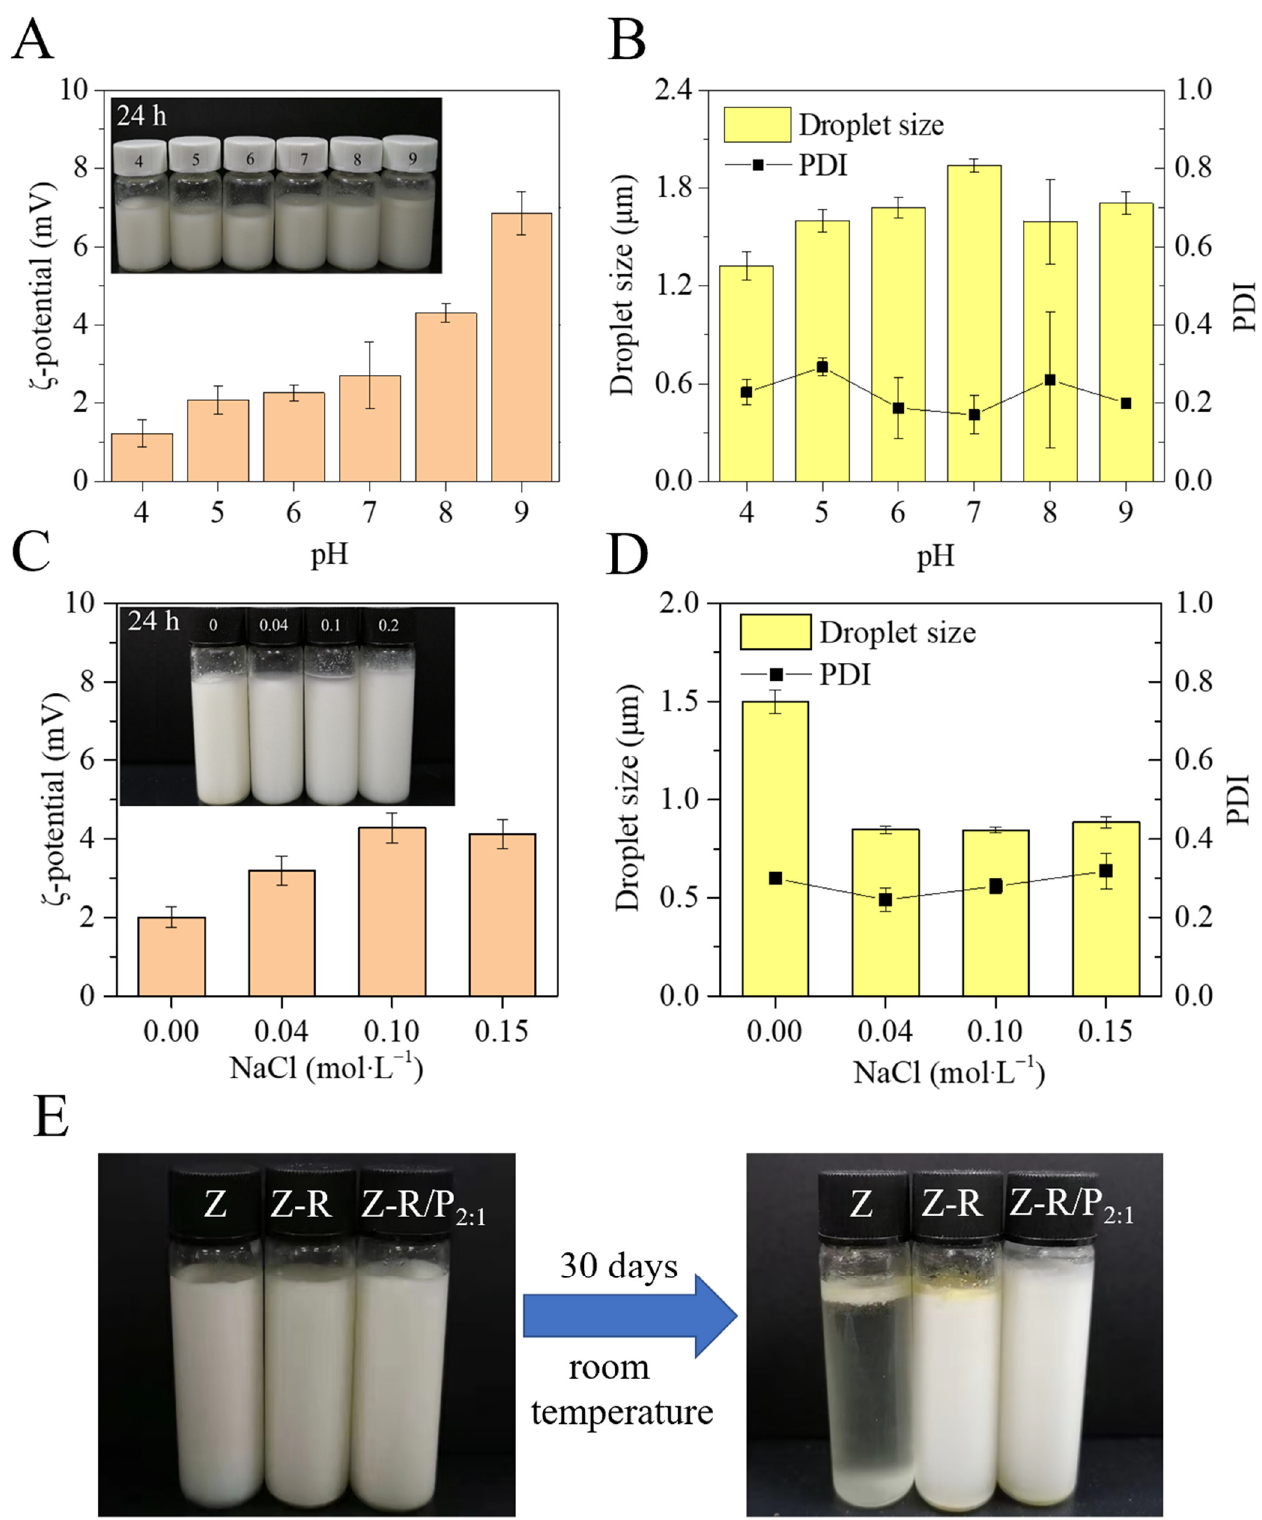
Figure 8. Effect of different pHs on the appearance, ζ -potential ( A ), droplet size and PDI ( B ) of Z-R/P 2:1 -stabilized emulsions after 24 h of storage. Effect of different NaCl concentrations on the appearance, ζ -potential ( C ), droplet size and PDI ( D ) of Z-R/P 2:1 -stabilized emulsions after 24 h of storage. The appearance ( E ) of emulsions stabilized by Z, Z-R and Z-R/P 2:1 particles before and after 30 days of storage at room temperature.